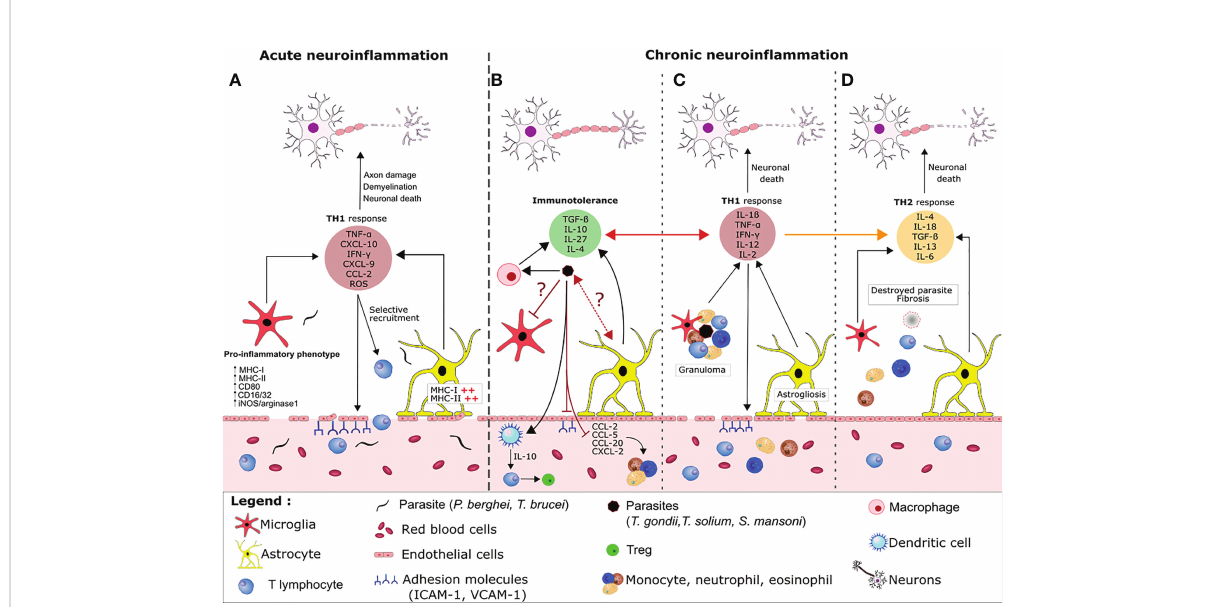
FIGURE 2 Host regulation of neuroimmune processes during acute versus chronic parasite infection. (A) During an acute parasite infection (e.g by P . falciparum or T . brucei ), parasites cross the BBB and activate astrocytes and microglia, which produce large amounts of pro-in fl ammatory cytokine/chemokines (e.g CXCL-10) that recruit T lymphocytes. Together, CD8 + and CD4 + T lymphocytes favor a pro-in fl ammatory environment by releasing molecules like perforin, granzyme, reactive oxygen species and IFN- g . This release leads to disruption of the BBB, which favors parasite entry, aggravates the brain in fl ammation, and causes collateral damage to neurons. (B) In contrast, immune tolerance and pro-in fl ammatory responses are balanced during a chronic parasite infection. The cysts release compounds that inhibit granuloma formation and the activation of resident glial cells. For example, the parasites polarize pro-in fl ammatory macrophages into anti-in fl ammatory macrophages, which suppress the production of adhesion molecules and the local TH1 response via TGF- b and IL-10 production. Other cyst- derived compounds polarize CD4 + cells into regulatory T cells (Tregs) by modulating the maturation of dendritic cells and preventing the in fi ltration and migration of neutrophils, eosinophils and monocytes from the peripheral system into the brain via the production of immunomodulatory cytokines and the blockade of chemokines and adhesion molecules. Through an as-yet unknown mechanism, the parasite also inhibits the activation of microglia and astrocytes. Nevertheless, some of the material released by the cysts elicits an in fl ammatory reaction (mainly characterized by the secretion of IFN- g and TNF- a by the activated glial cells and leukocytes). The chemoattractants lead to the recruitment of neutrophils, eosinophils and monocytes, which form a granuloma. Formation of a granuloma limits the collateral damage caused by the TH1 response and enables the parasite to be contained and destroyed. The astrocytes and microglia become activated and the BBB is damaged (C) . Progressively, the TH1 response is replaced by a TH2 response and fi brosis occurs where the cyst was located. This fi brosis is associated with neuronal damage (D)